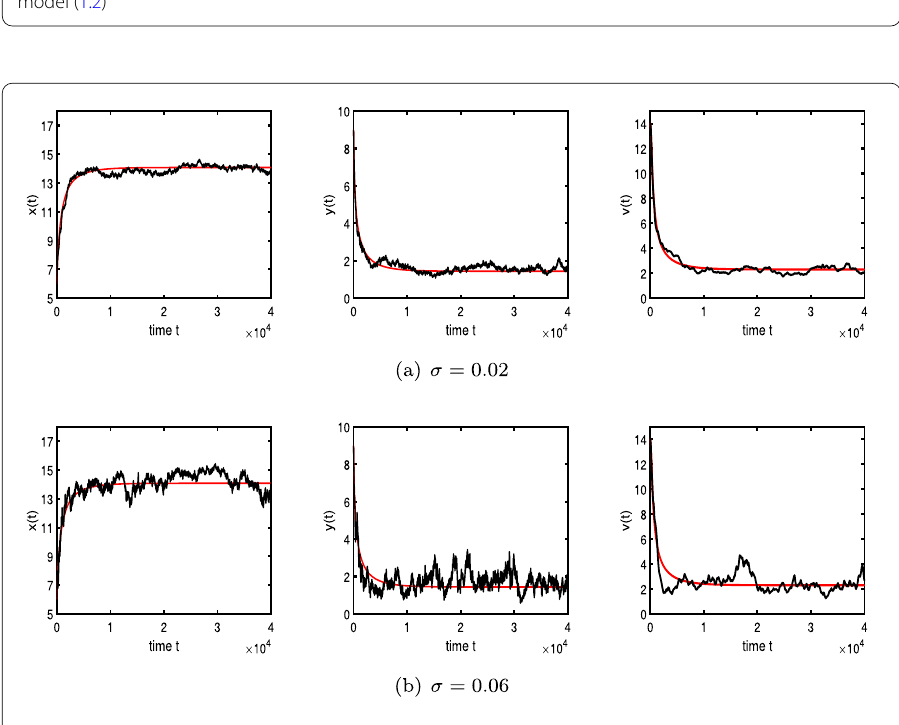
Figure 2 Given R 0 > 1, the relationship between trajectories of deterministic model (1.1) and stochastic model (1.2)